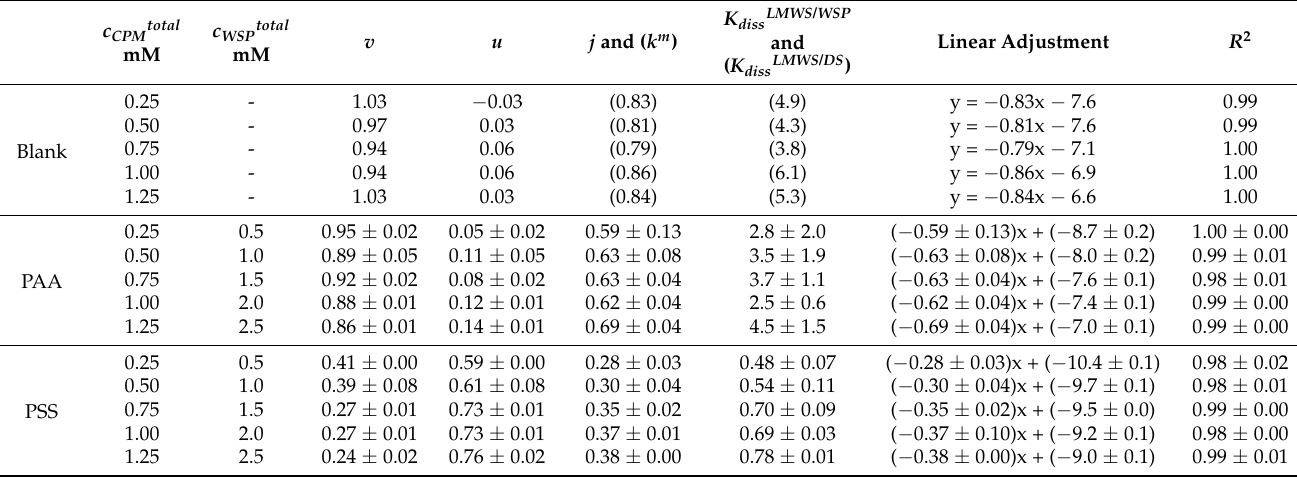
Table 1. WSP n /CPM n/2 system formulations, the resulting DF parameters, and the linear adjustment of the DF profiles with the corresponding linear regression factors ( R 2